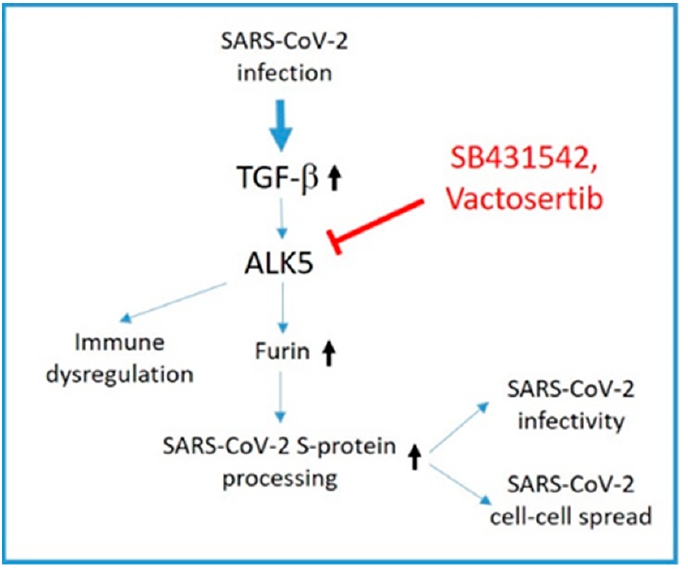
Figure 8. ALK5 inhibition as a potential therapy option for SARS-CoV-2 infection. SARS-CoV-2 infection leads to upregulation of TGF- β and subsequent ALK5 activation. As shown in this study, ALK5 activation induces furin expression which fosters SARS-CoV-2 S-protein processing. This increases SARS-CoV-2 infectivity and cell–cell spread. ALK5 inhibition by SB431542 or Vactosertib interferes with furin upregulation and may also block TGF- β driven immune dysregulation.